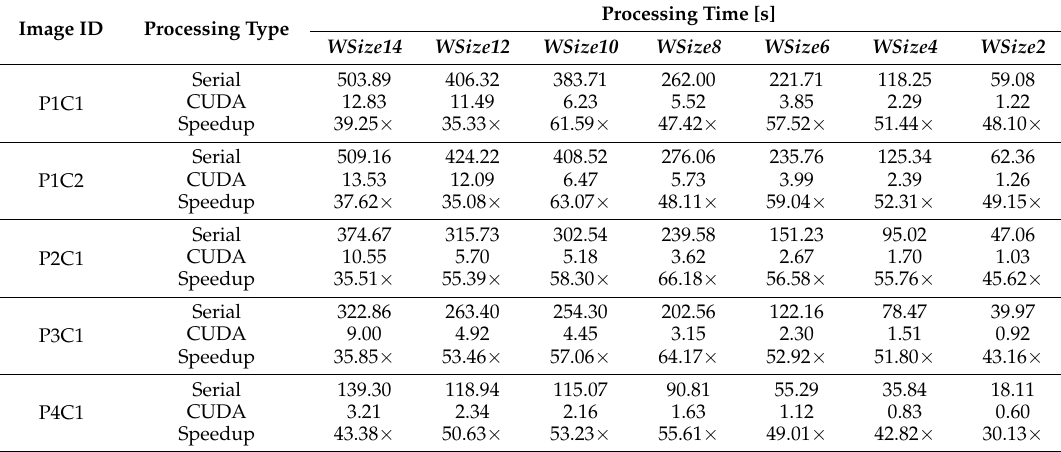
Table 3. Execution time results of the serial and parallel implementations using the Euclidean distance employing different window